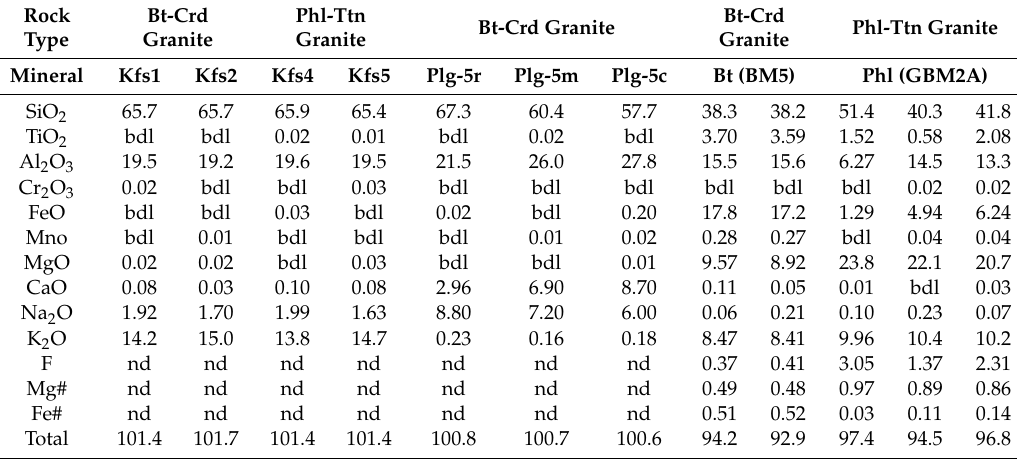
Figure 4. Quantitative Evaluation of Minerals by Scanning Electron Microscopy (QEMSCAN) images of two granite samples. ( A ) Thick overgrowth of oligoclase (An 10–15 ) on andesine plagioclase (An 35–45 ). ( B ) K-feldspar replace albite and increases from 30 vol. % to about 50 vol. %. Table 2. Selected scanning electron microscopy coupled with energy dispersive spectroscopy (SEM-EDS) and electron microprobe analyses for minerals from the Botro ai Marmi (BM) granite.